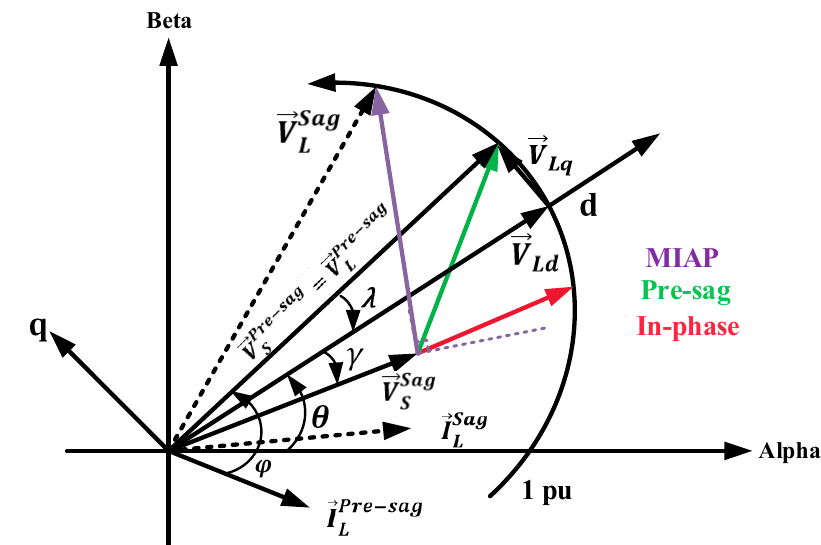
Figure 3. The diagram of pre-sag, in-phase, and minimum injection active power compensation strategies of the DVR.